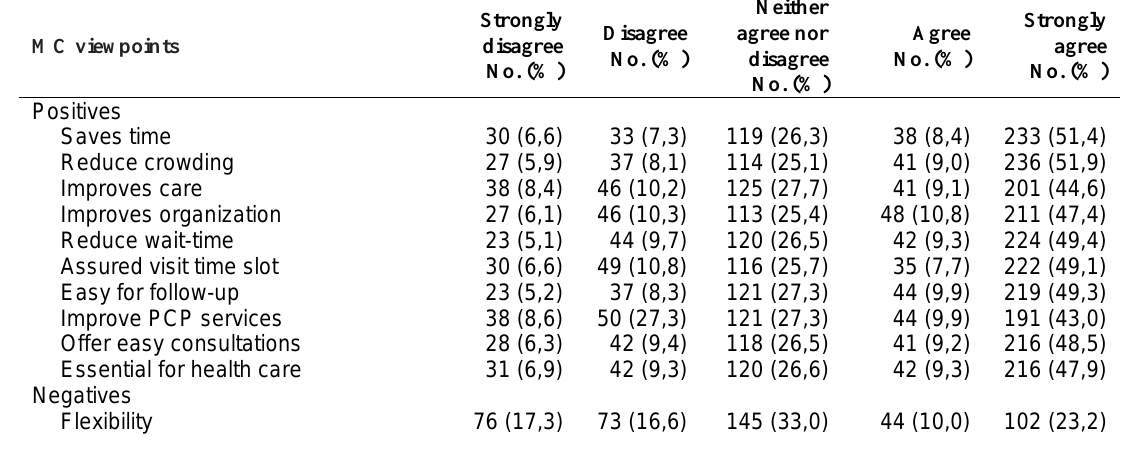
Table 4. MC Viewpoints on possible positives/negatives and help against Covid-19 spread by using